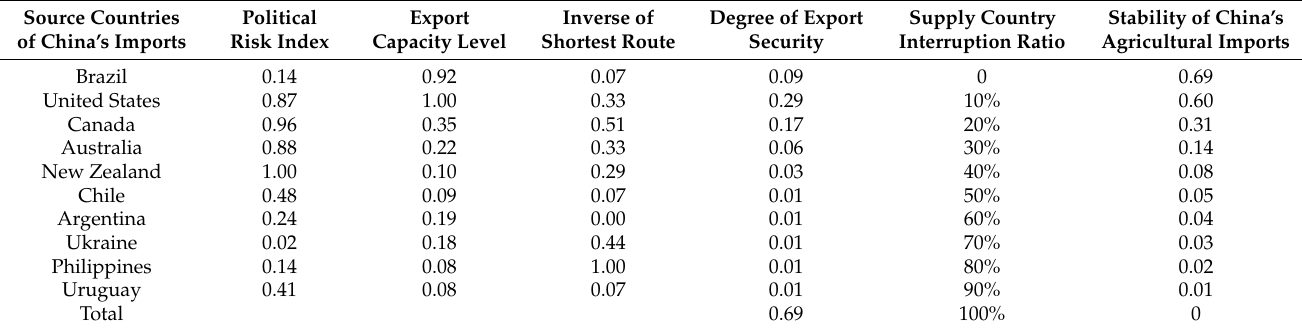
Table 2. Stability of China’s agricultural imports in